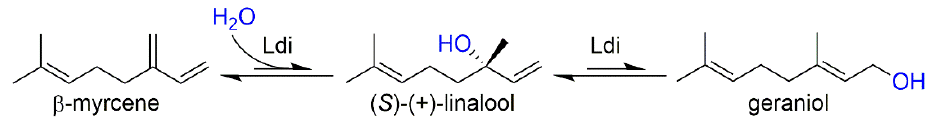
Scheme 1. Ldi-catalyzed hydration of β -myrcene to ( S )-( + )-linalool and its subsequent isomerization to